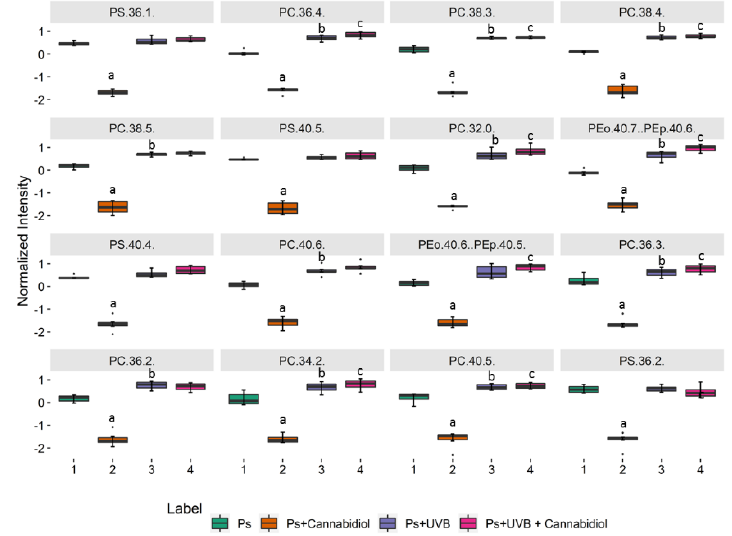
Figure 6. Boxplots of the 16 most discriminating PL molecular species (according to Kruskal–Wallis and post hoc Dunn’s multiple comparison tests) identified in keratinocytes isolated from the skin of psoriatic patients (Ps). These cells were not treated or treated with CBD (4 μM) or/and UVB (60 mJ/cm 2 ). The following groups of keratinocytes were examined: Ps, Ps + CBD, Ps + UVB and Ps + UVB + CBD. p < 0.05 was considered statistically significant: a , Ps vs. Ps + CBD; b , Ps vs. Ps + UVB; c , Ps vs. Ps + UVB + CBD.